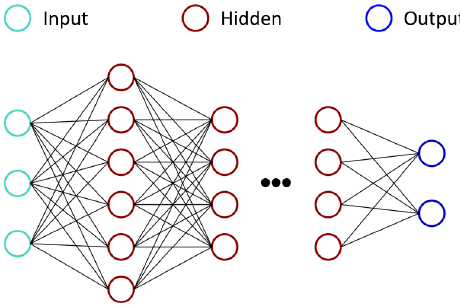
Figure 2. An example of deep neural network architecture.